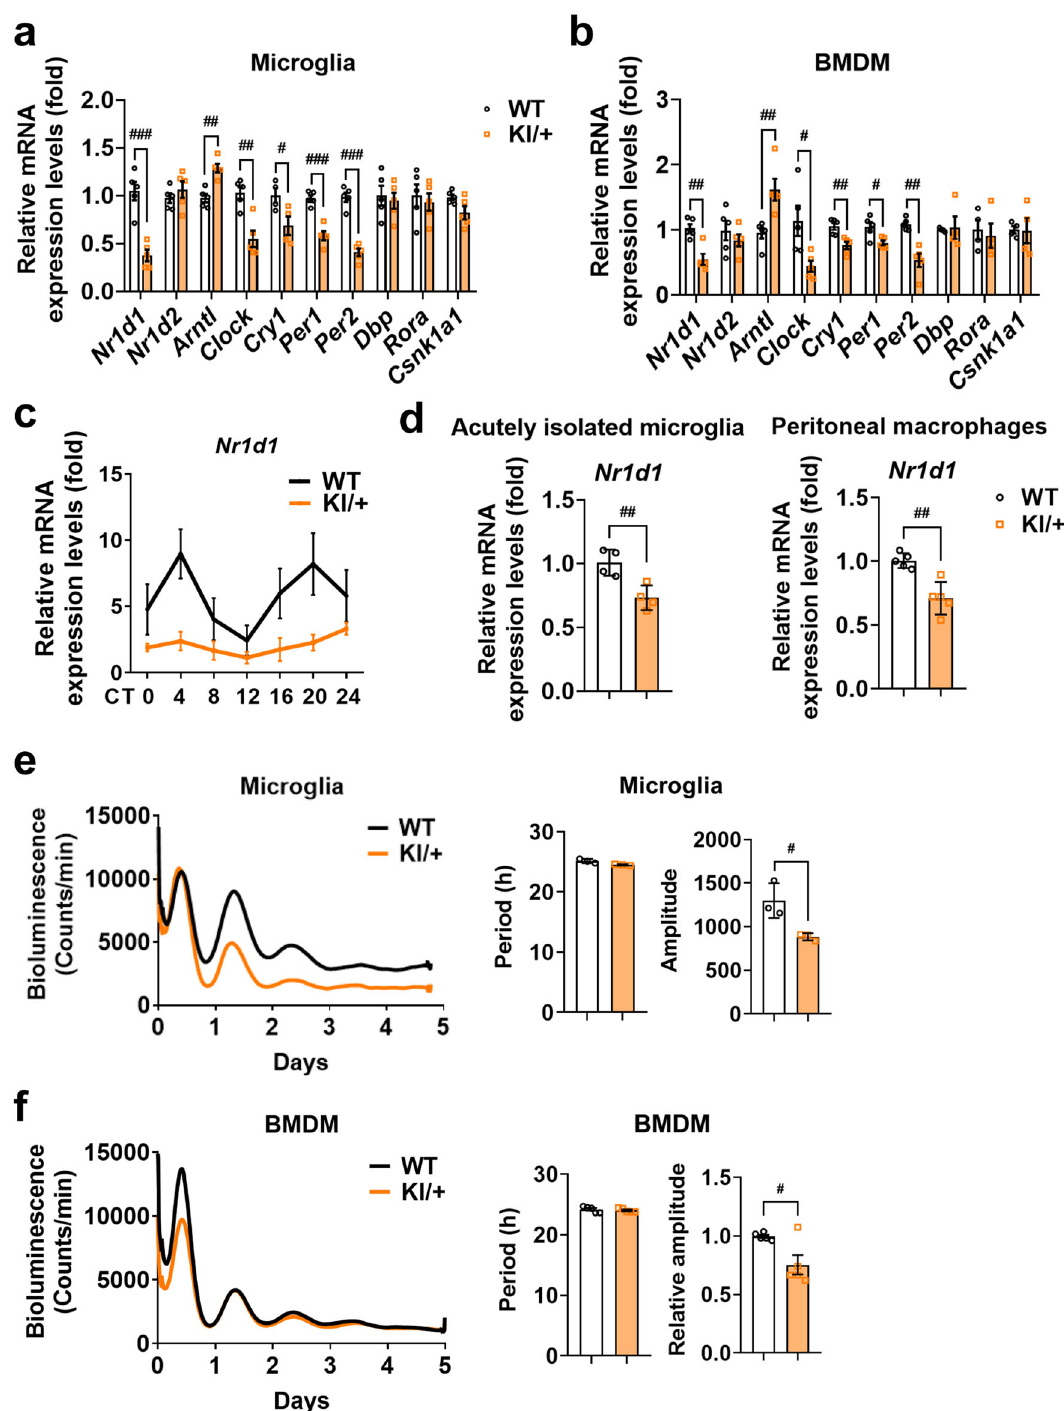
As expected, the expression of human NR1D1 in KI/ + microglia was suf fi cient to revert the response of IL-6 to LPS to the WT levels (Fig. 6g, h). In addition, the mRNA (Supplementary Fig. 5c) and secretion levels (Supplementary Fig. 5d) of other clock- controlled cytokines were reduced with overexpression of Nr1d1 . In contrast, the secretion and transcript level of TNF- α were not impacted by modulating REV-ERB α expression in microglia (Fig. 6d, e, g, h). These data indicate that the Psen2 N141I mutation selectively elevates clock-controlled cytokines produc- tion in response to LPS through downregulation of REV-ERB α in